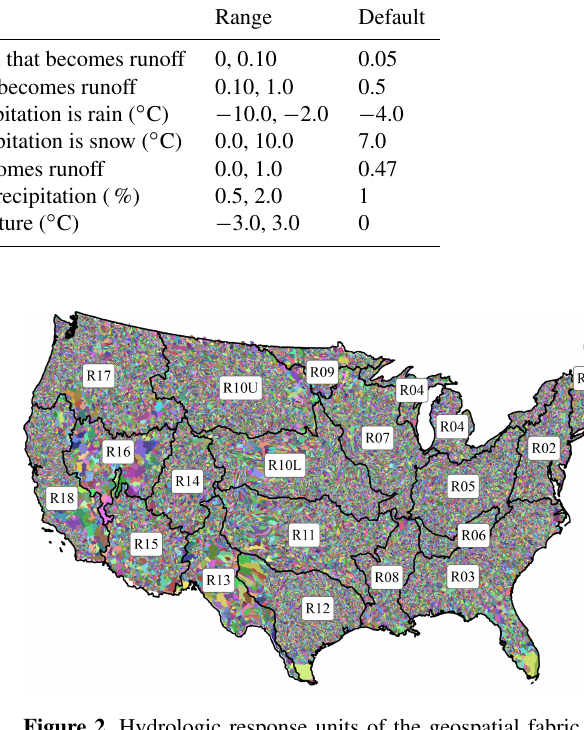
Figure 2. Hydrologic response units of the geospatial fabric, dif- ferentiated by color, overlain by NHDPlus region boundaries (R01–